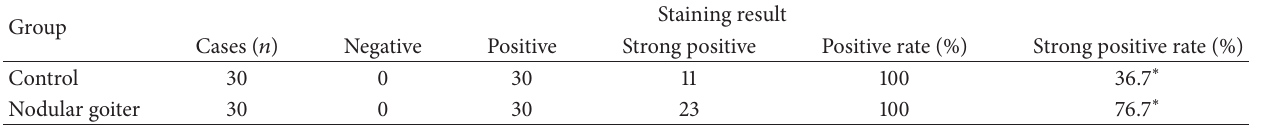
Table 3: Immunohistochemistry detecting PAX8 in control and nodular goiter groups.